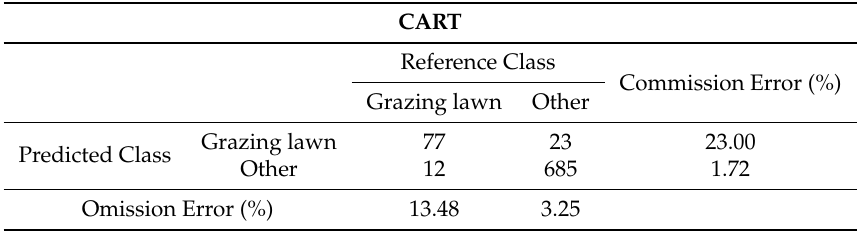
Table A4. Confusion matrix summarising results from Classification and Regression Trees (CART) model classification of grazing lawn and other cover.